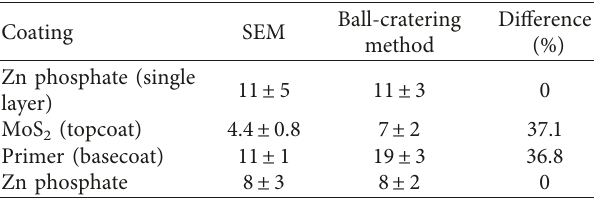
Figure 2: (a) SEM image of cross-sectional areas of the MoS coating system and (b) the surface after the ball-cratering method. Table 2: Thickness values ( μ m) obtained in SEM (transversal section) and the ball-cratering method and the respective differ- ences (%) between them.